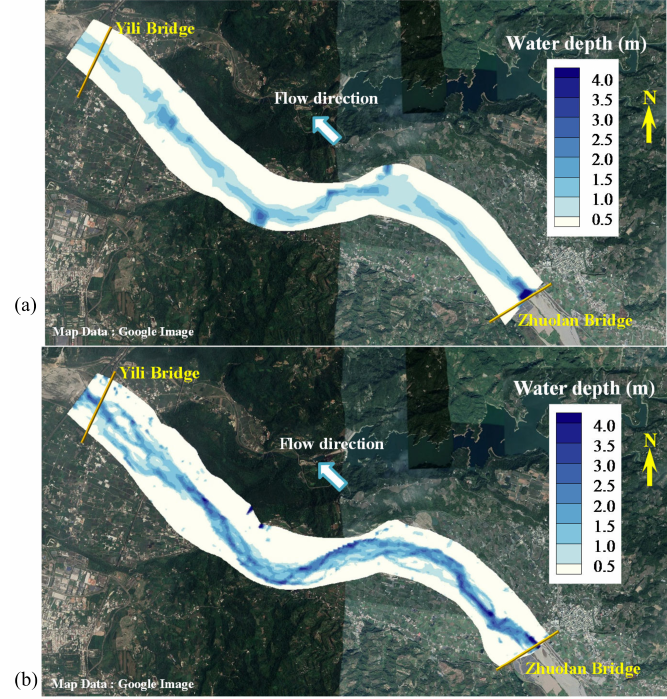
Figure 10. Contour plots showing the water depths based on ( a ) coarse and ( b ) fine computational meshes for Typhoon